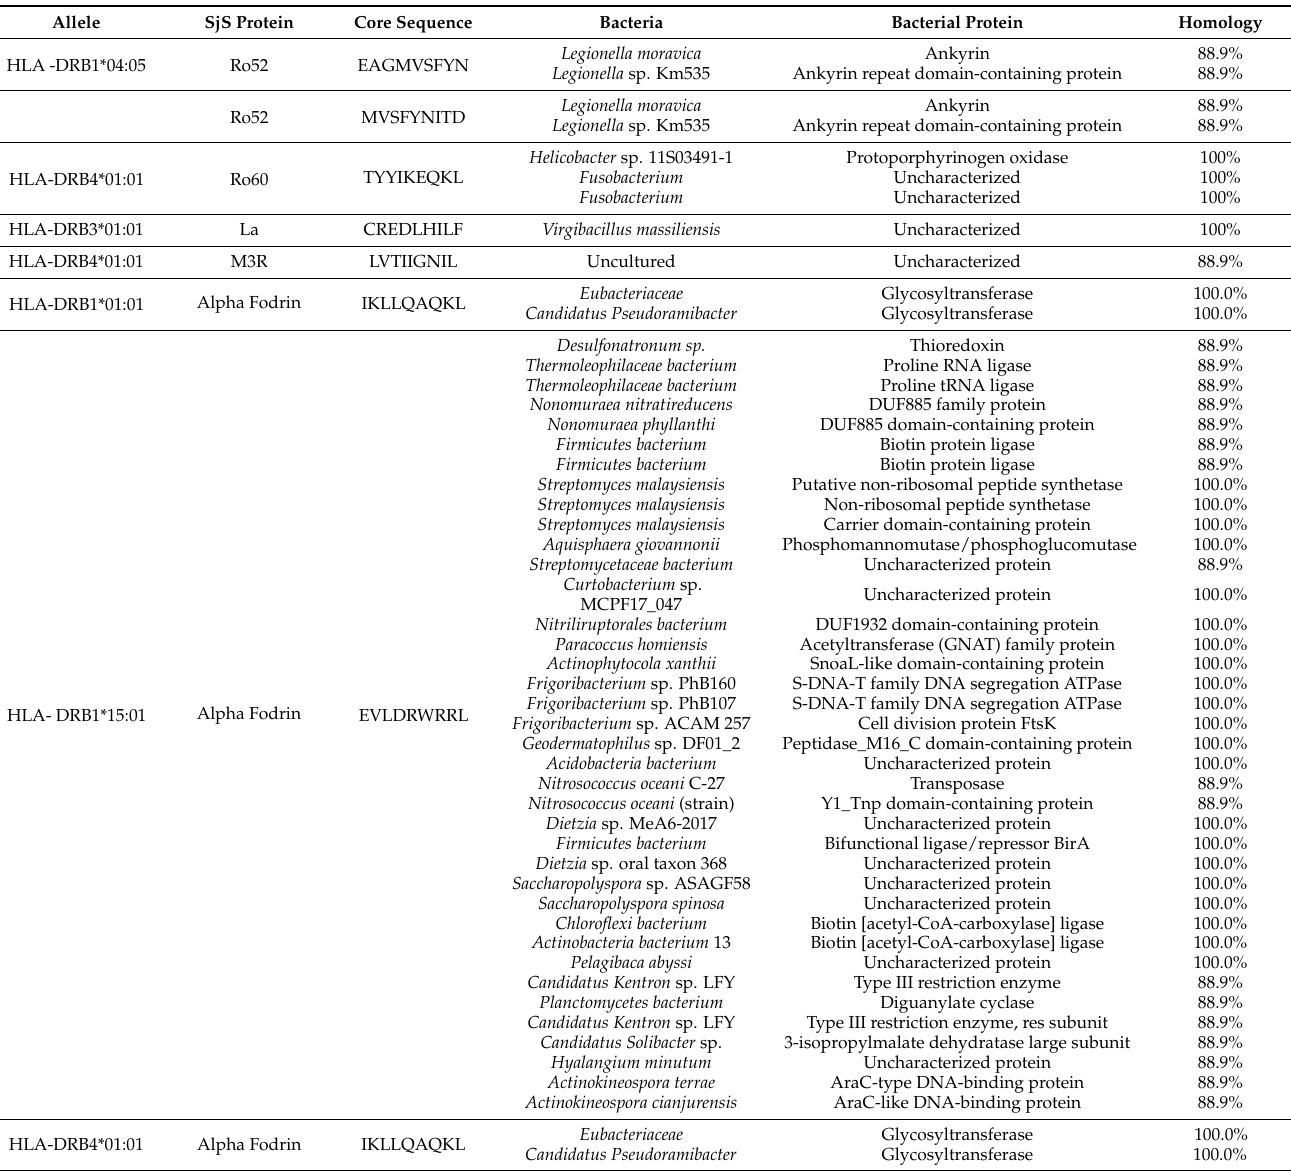
Table 17. Homology of predicted peptides binding to HLA alleles to bacterial